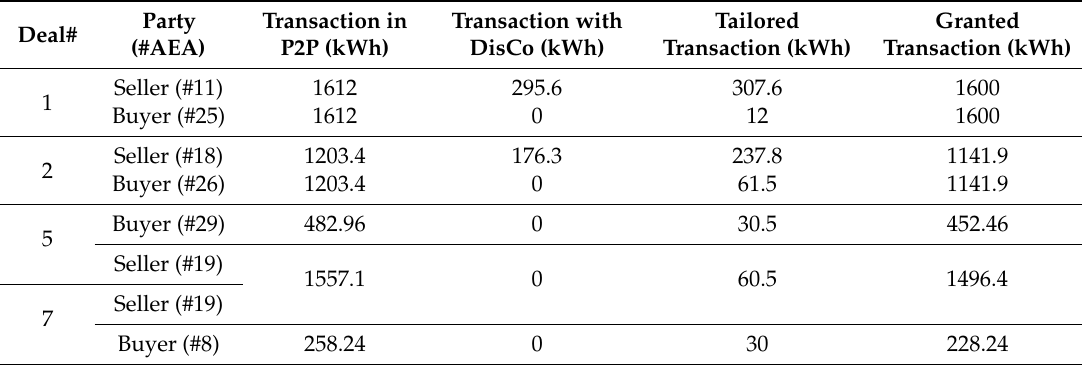
Table 5. A ff ected orders and tailored